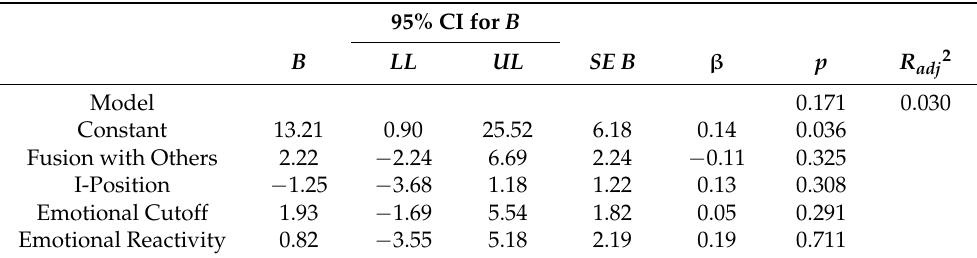
Table 7. Differentiation of self-inventory-short form as a predictor for psychological adjustment to separation test former partner attachment subscale.